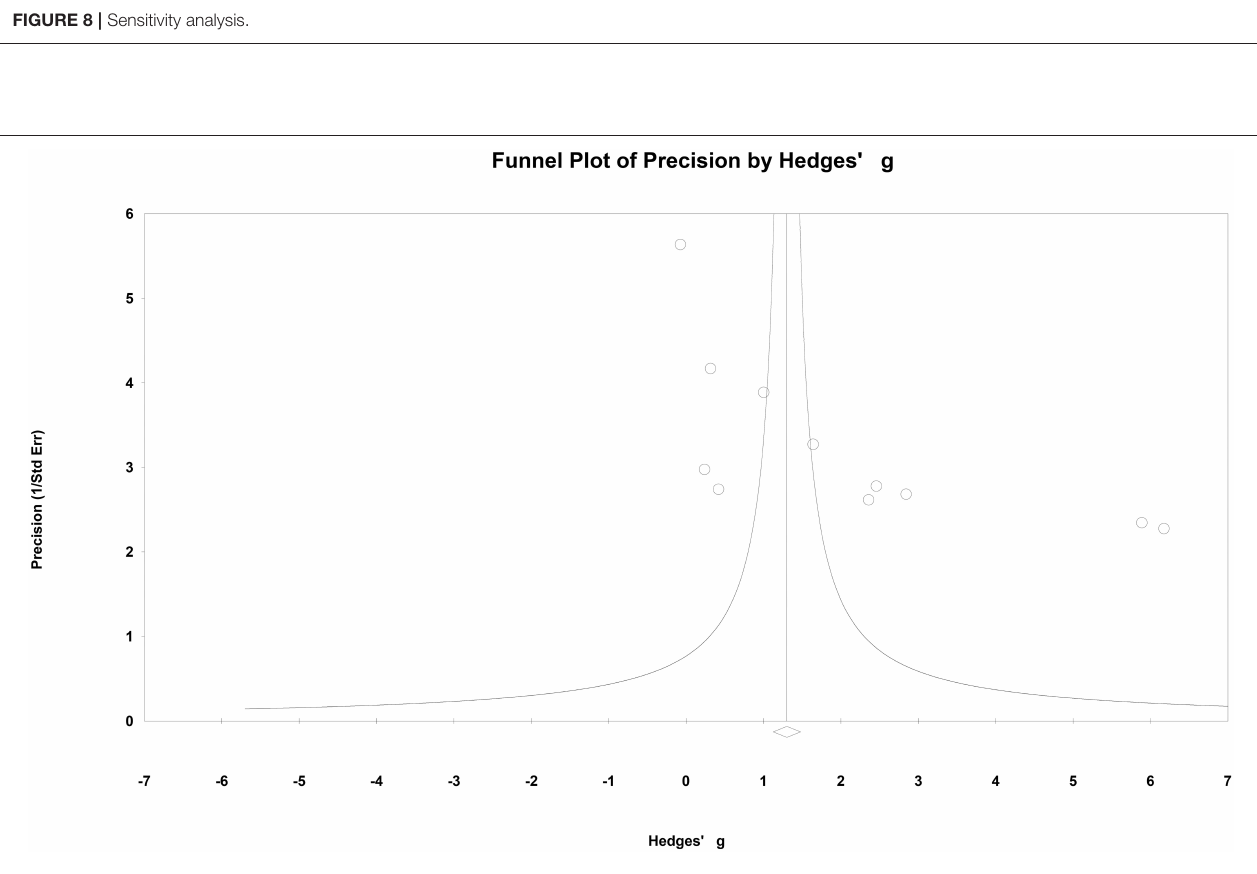
FIGURE 9 | Funnel plot of precision using Hedges’ g